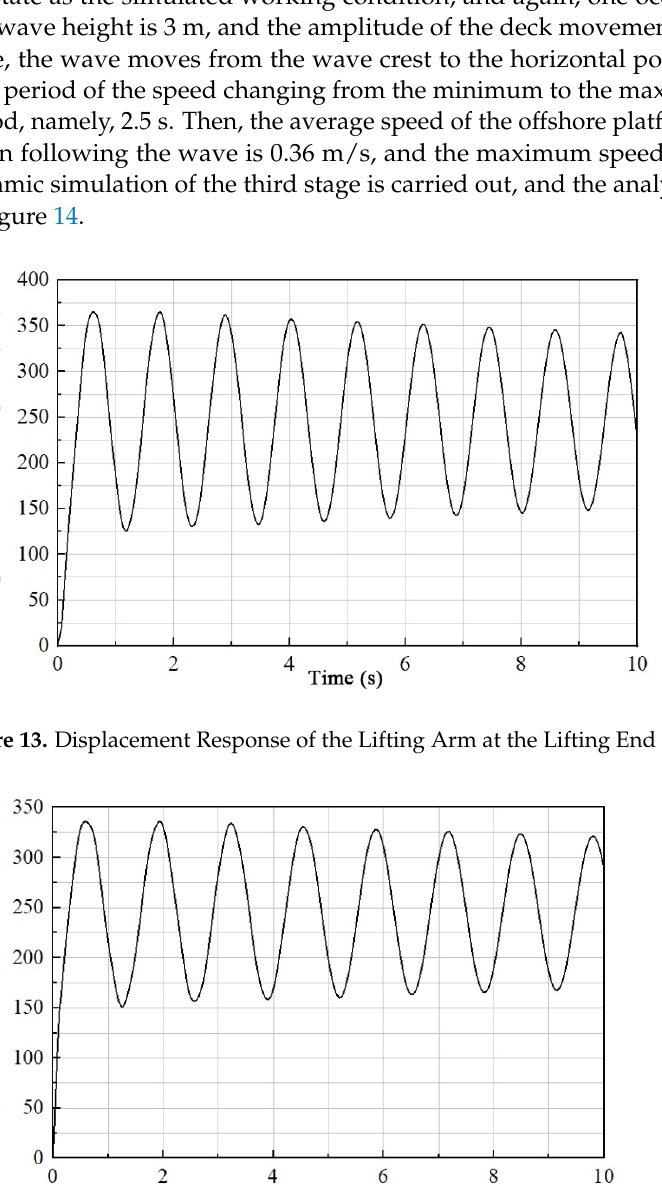
Figure 13. Displacement Response of the Lifting Arm at the Lifting End in the Second Stage.